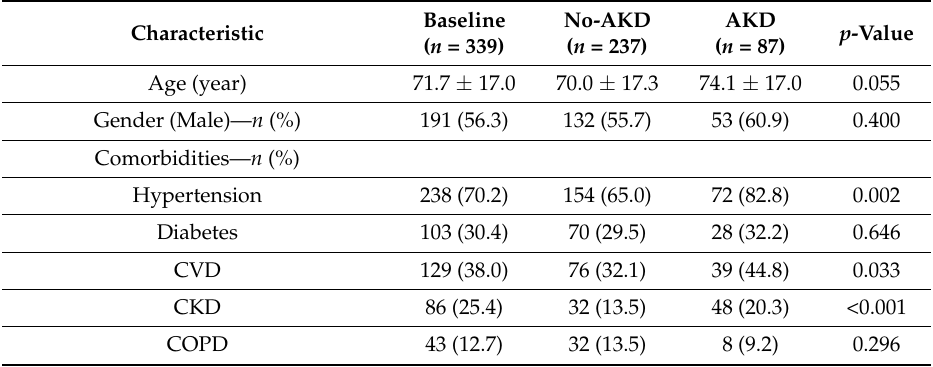
Table 1. Patients’ baseline characteristics and according to AKD